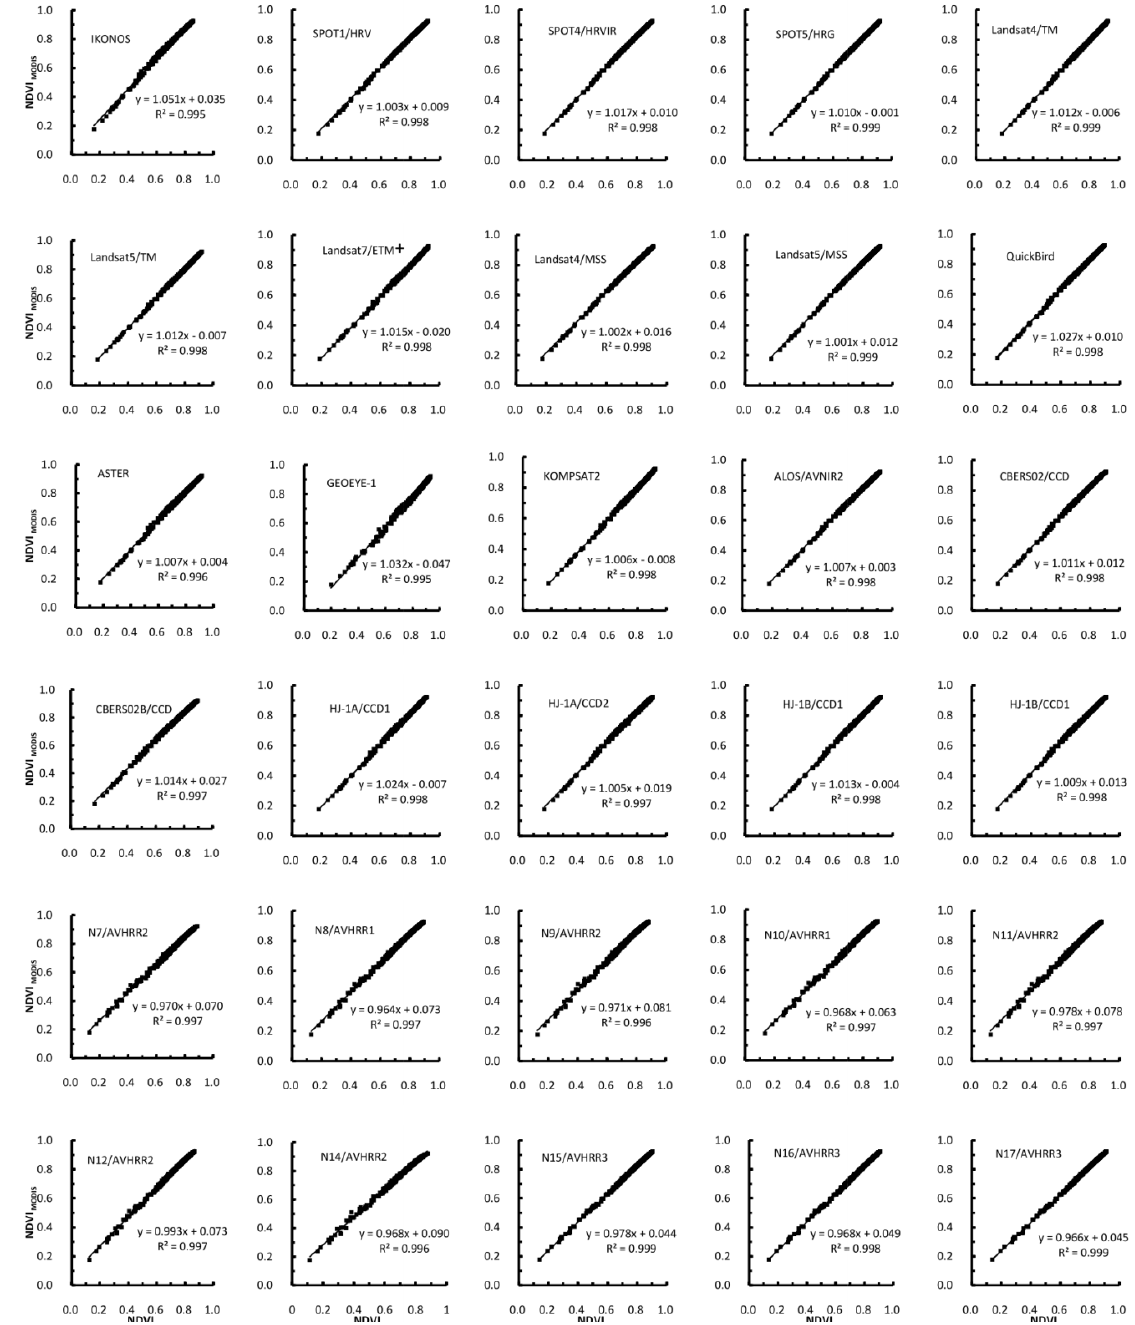
Figure 8. Interrelationships between the NDVIs from selected pairs of